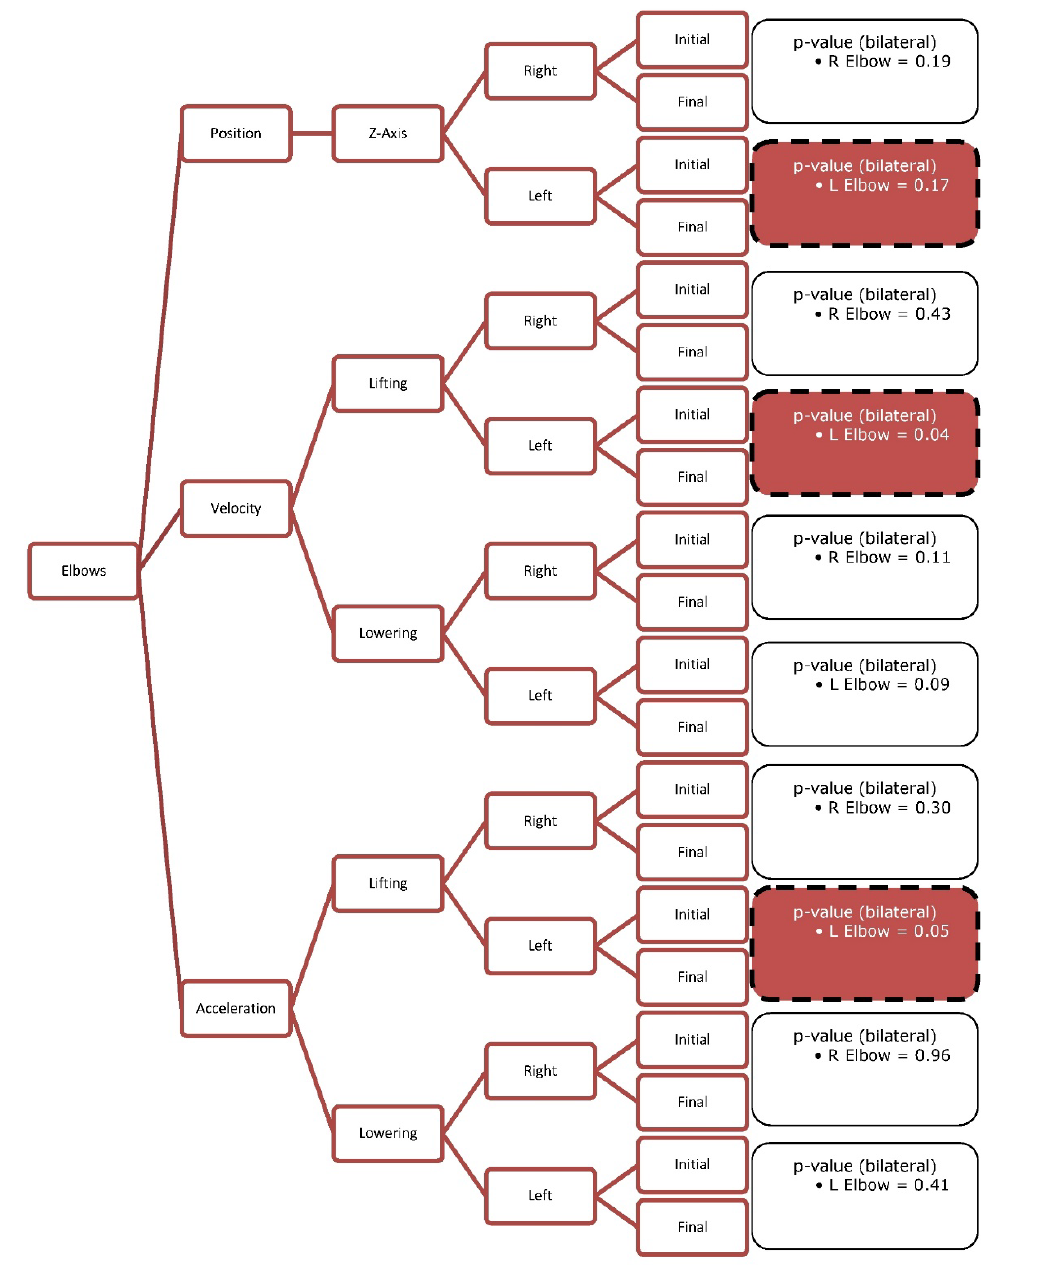
Figure 10. Elbows Student's paired t-test